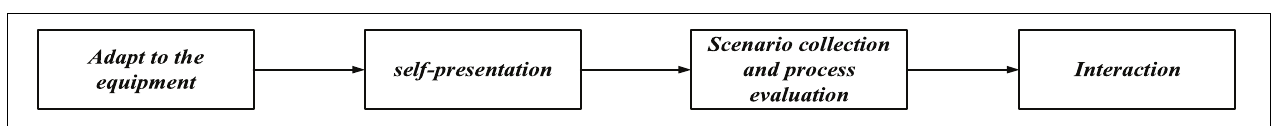
FIGURE 5 | Virtual reality (VR)-based Sand Table game treatment process.